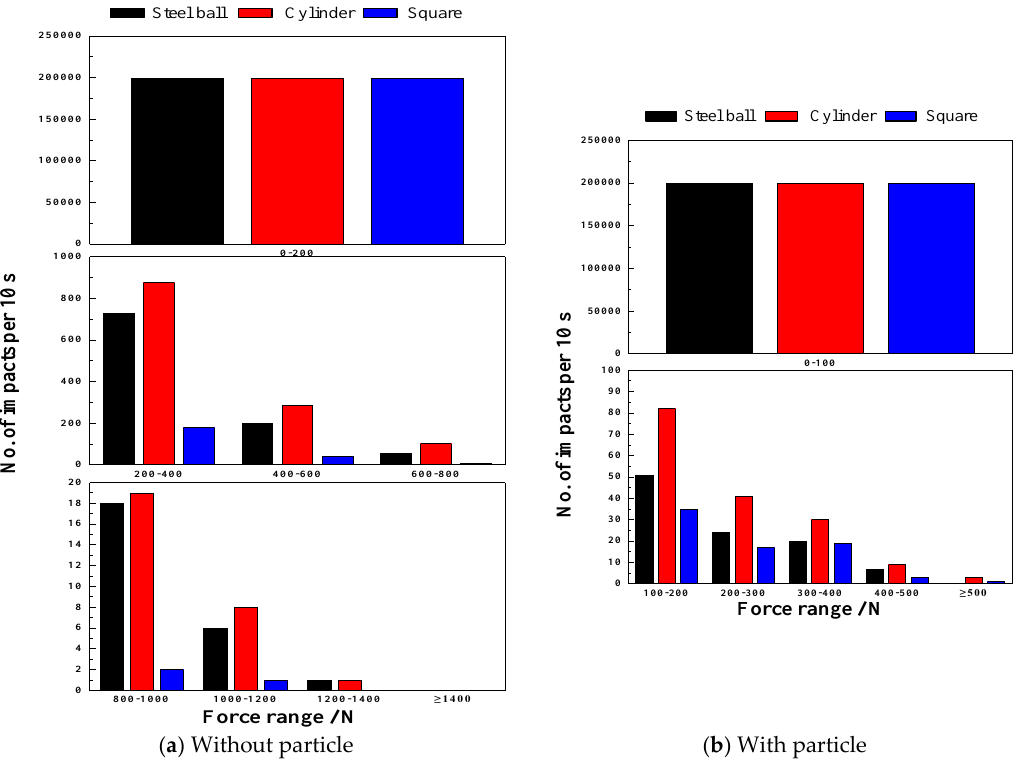
Figure 15. Effect of particle on impact force. ( a ) Without particle; ( b ) With particle.